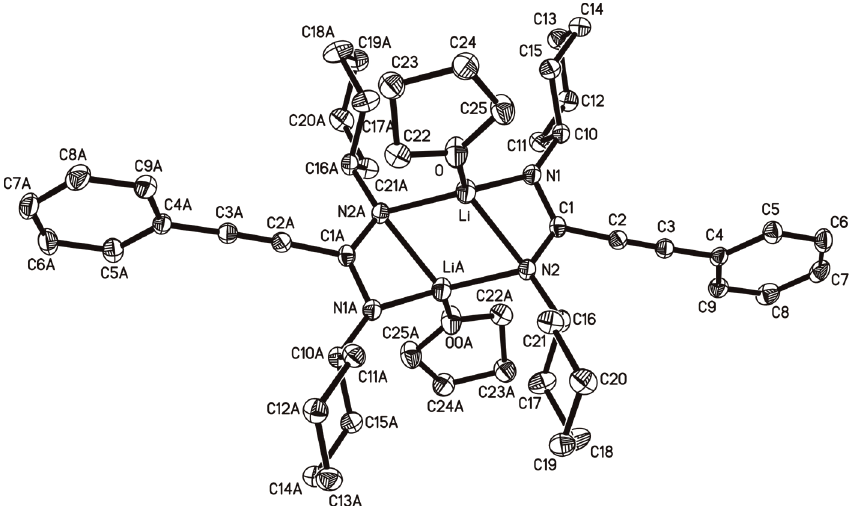
Figure 2. Molecular structure of 2 in the crystal, showing the atom-labeling scheme. Displacement ellipsoids are drawn at the 50% probability level. Selected bond lengths (Å) and angles (°): O–Li 1.9518(19), N(1)–C(1) 1.3201(13), N(1)–Li 2.031(2), N(2)–Li